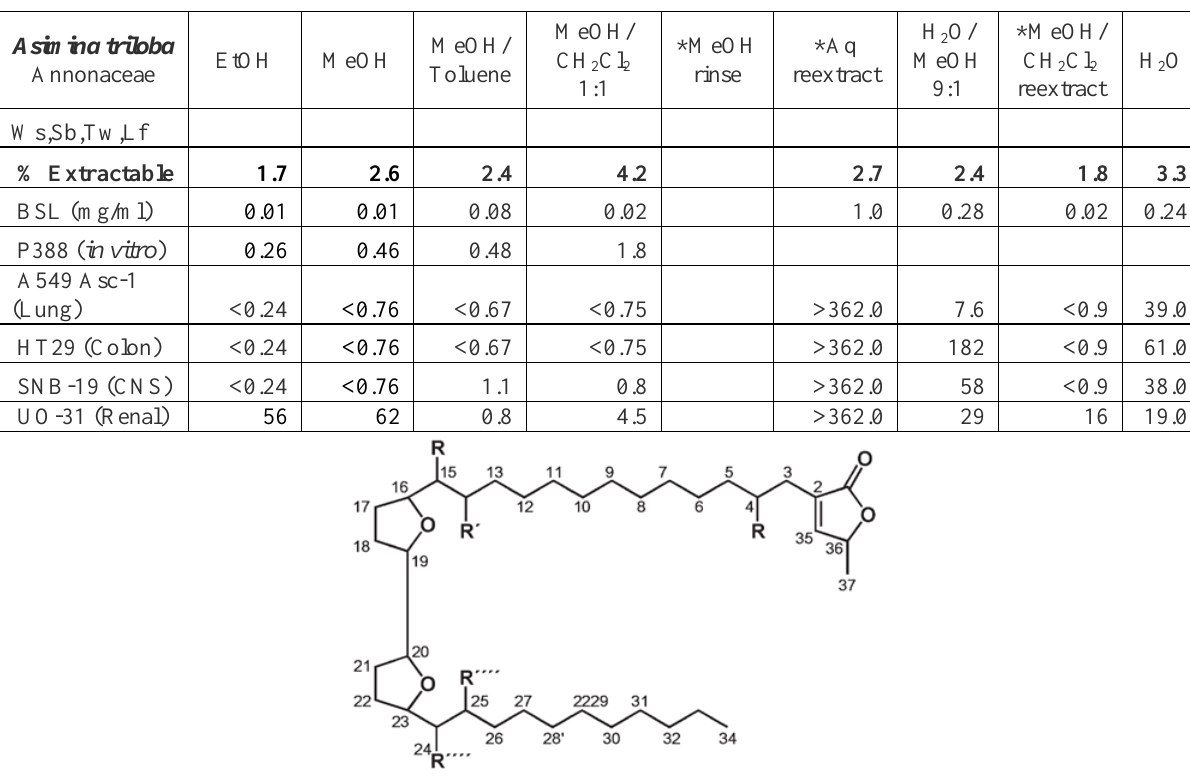
Table 2. Bioactivities obtained from extracts when produced by various solvents and in different orders. [EtOH is lab grade un-denatured 95% EtOH. P388 is a mouse leukemia cell line. BSL is lethality to brine shrimp ( Artemia salina ) carried out as described by Meyer, et al . [7], expressed in mg/mL. Other cell lines are human-cancer derived, members of the NCI 60 cell line panel [3], with toxicity expressed as µg/mL.] * indicates re- extraction of a